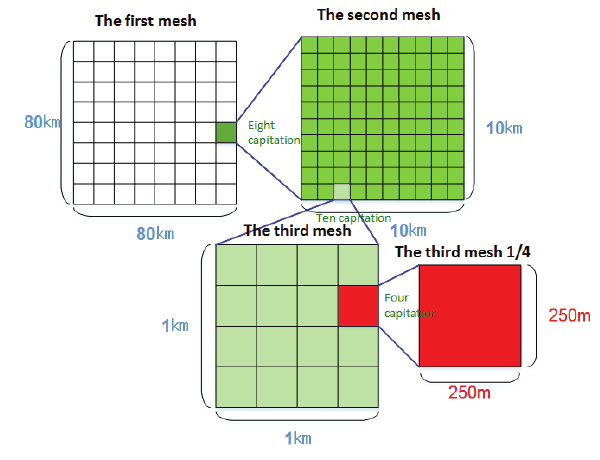
Figure 2. Mesh structure